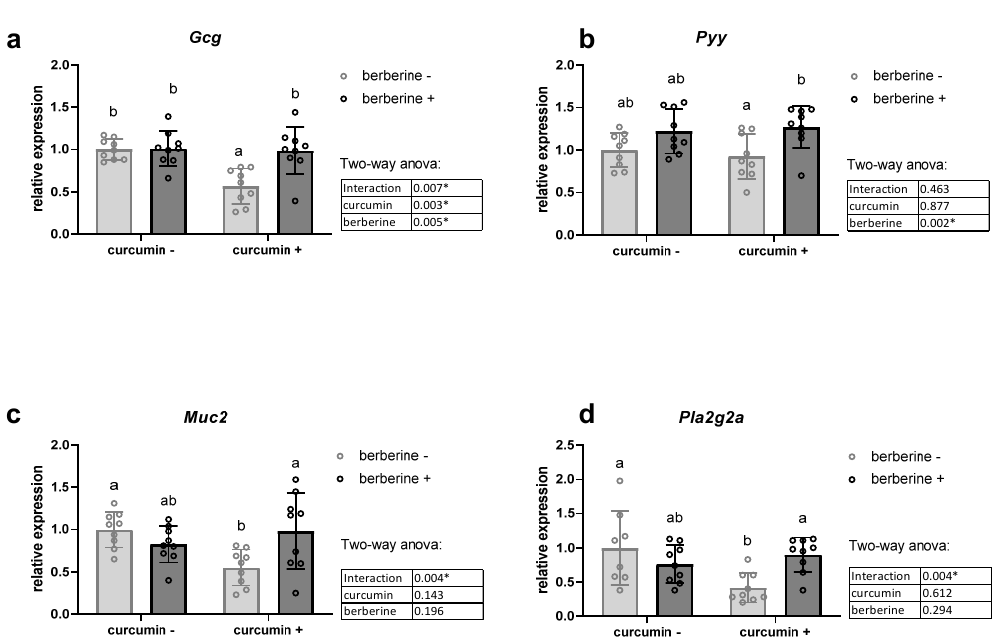
Figure 2. Colonic mRNA level coding for host peptides in the colon. Gcg coding for glucagon-like peptides (GLP-1, GLP-2) ( a ), Pyy coding for peptide YY ( b ), Muc2 coding for mucin 2 ( c ) and Pla2g2a coding for phospholipase A2 group II ( d ). Ob/ob mice were fed a standard diet supplemented with or without berberine or curcumin for 4 weeks ( n = 9 for each group). * p < 0.05 for berberine or curcumin effect (two-way ANOVA). Data with different superscript letters are significantly different at p < 0.05 (Tukey post-hoc test).